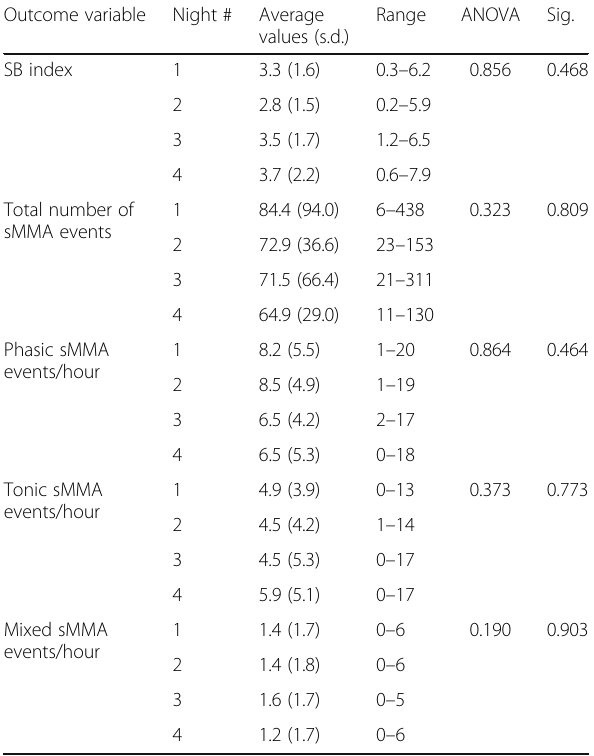
Table 4 Average values (standard deviation (s.d.)) of outcome variables over each recording night and ANOVA test for significant differences Outcome variable Night # Average values